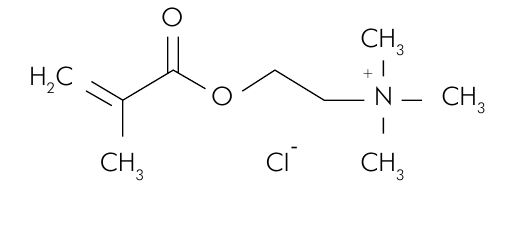
Figure 1. Chemical structure of [2-(methacryloyloxy)ethyl] trimethylammonium chloride